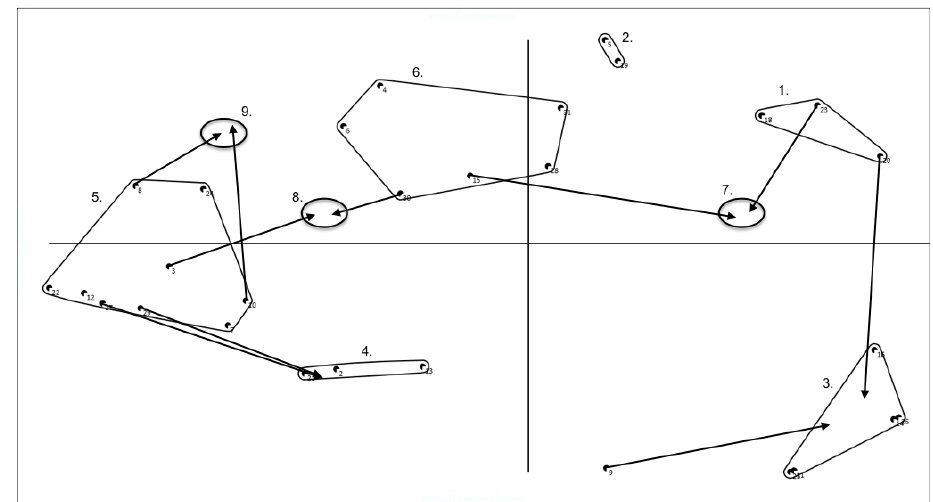
Figure A2. Concept map children (school 3). Note that points, i.e., statements, sorted more often together appear closer to each other, and statements never/rarely sorted together appear widely separated; Arrows indicate a statement is reallocated by researchers, circles indicate a new cluster is created by researchers as a result of reallocation of statements; Cluster 1: I sit because it is the norm/I sit because I have to; Cluster 2: I sit because there is nobody to play with; Cluster 3: I sit because seated activities are fun; Cluster 4: I sit because I’m tired, I want to relax, I want to rest; Cluster 5: I sit because I’m not in the mood to do anything; Cluster 6: I sit because there is nothing to do; Cluster 7: I sit because this posture suits the activity better; Cluster 8: I sit because of the weather; Cluster 9: I sit because the physical environment suitable for physical activities is too far away.